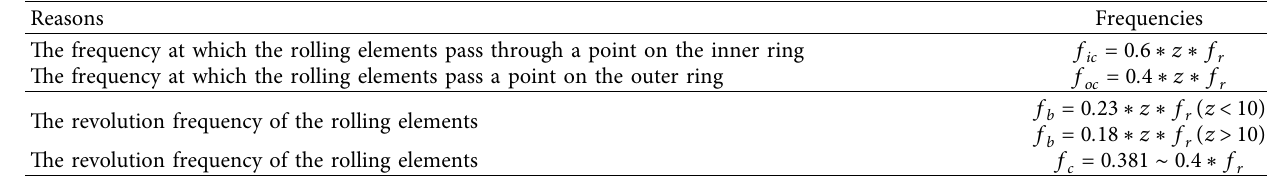
Table 2: Bearing noise empirical